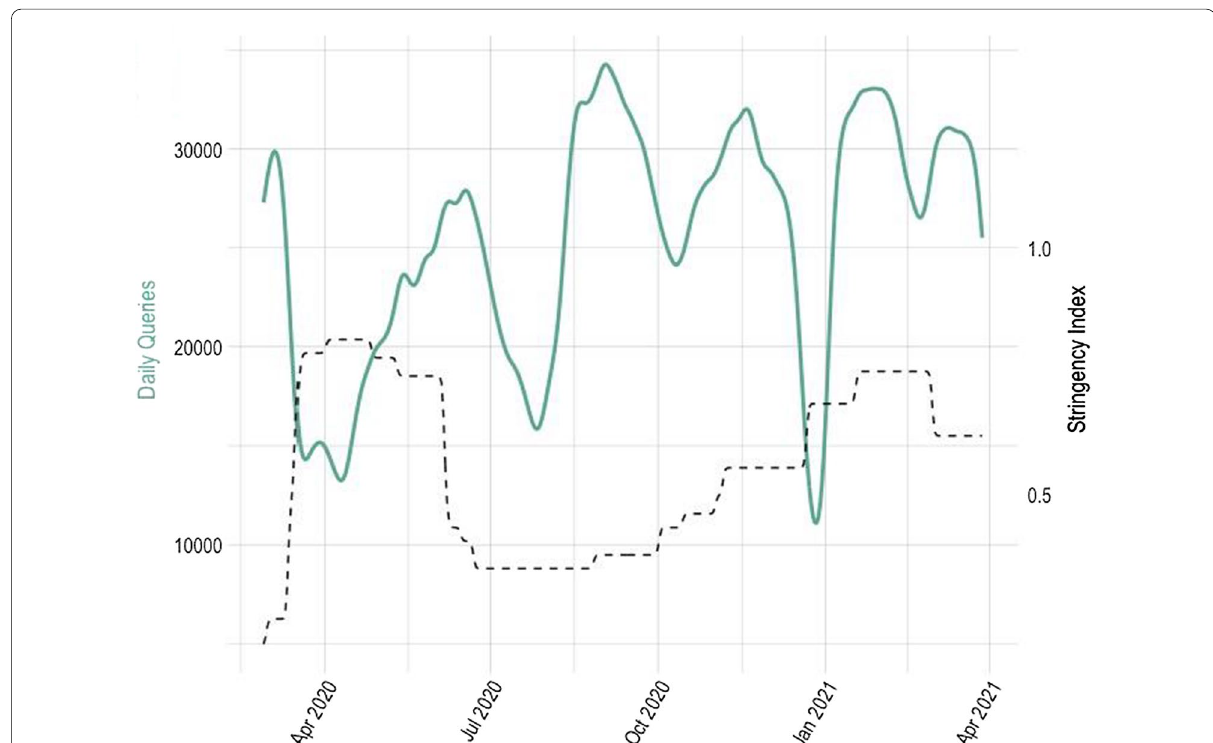
Fig. 2 Total daily queries and Stringency Index. Green solid line represents the daily queries, Nadaraya-Watson Kernel-smoothed (left axis), the black broken line is the Stringency Index (right axis), exemplarily for the canton Zurich